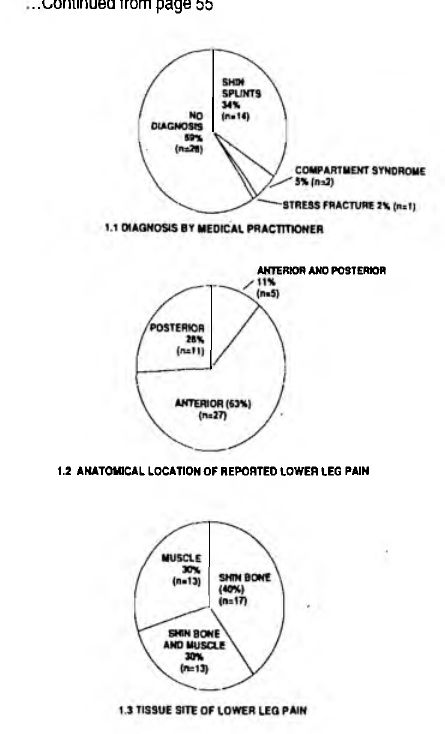
Figure 1: Diagnosis and presentation of lower leg pain in schoolgirl hockey players the shin bone and 48% (n-20) could localise one very tender spot on the shin bone.